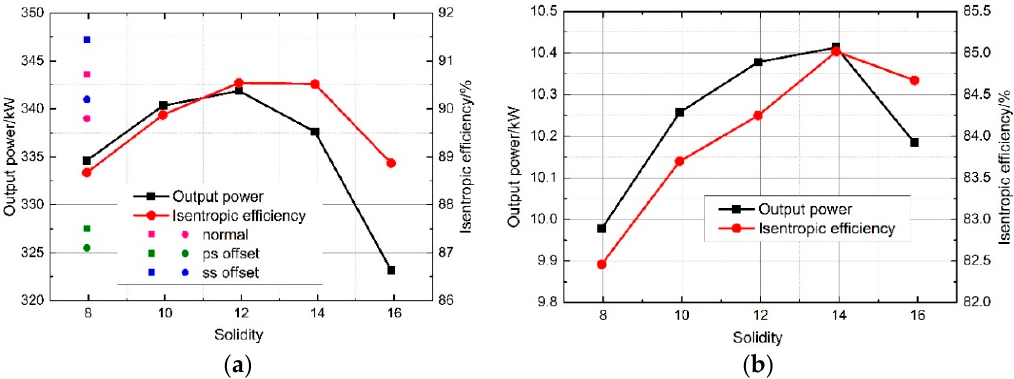
Figure 17. Output power and isentropic efficiency of different solidity and splitters: ( a ) SCO 2 ; ( b )